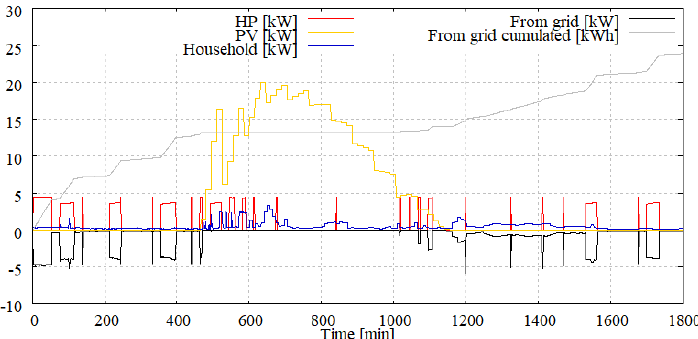
Figure 5. Single building daily electrical demand without optimization.